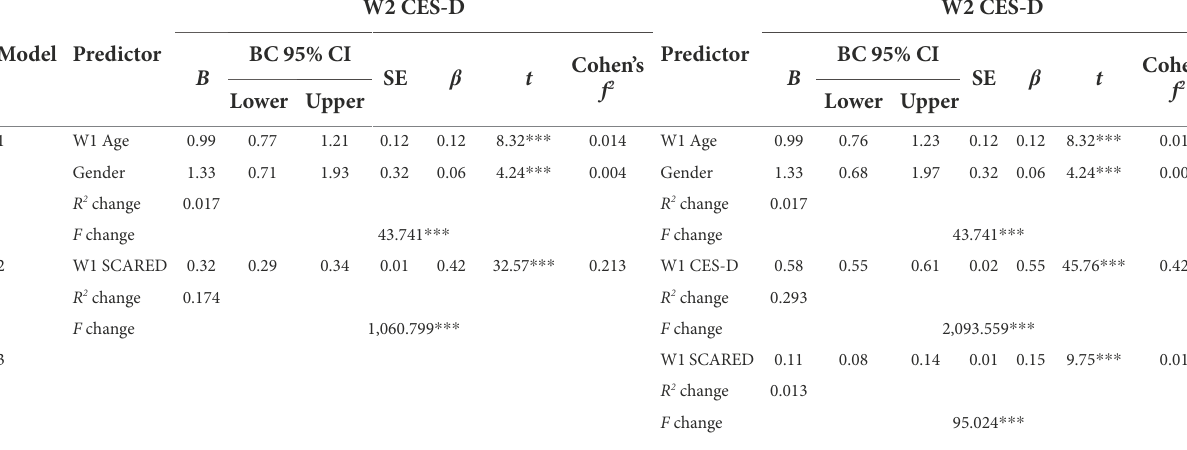
Model Predictor